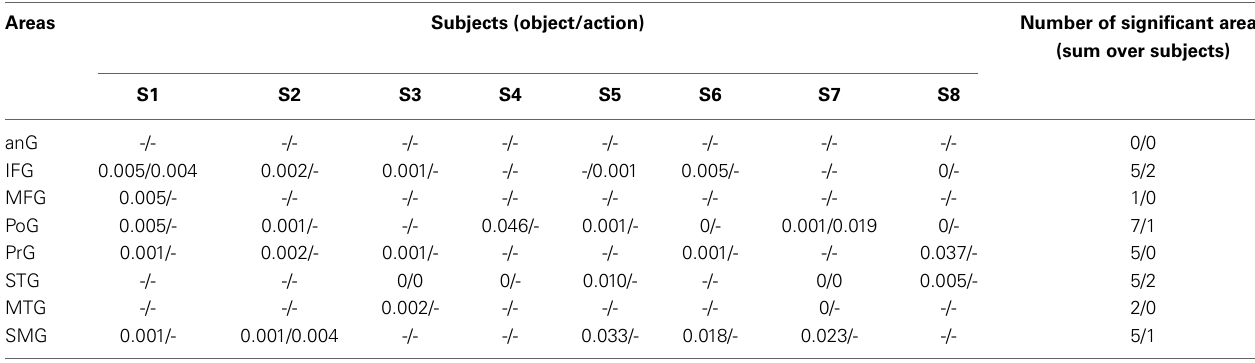
Table 2 | Single subject analysis within cortical